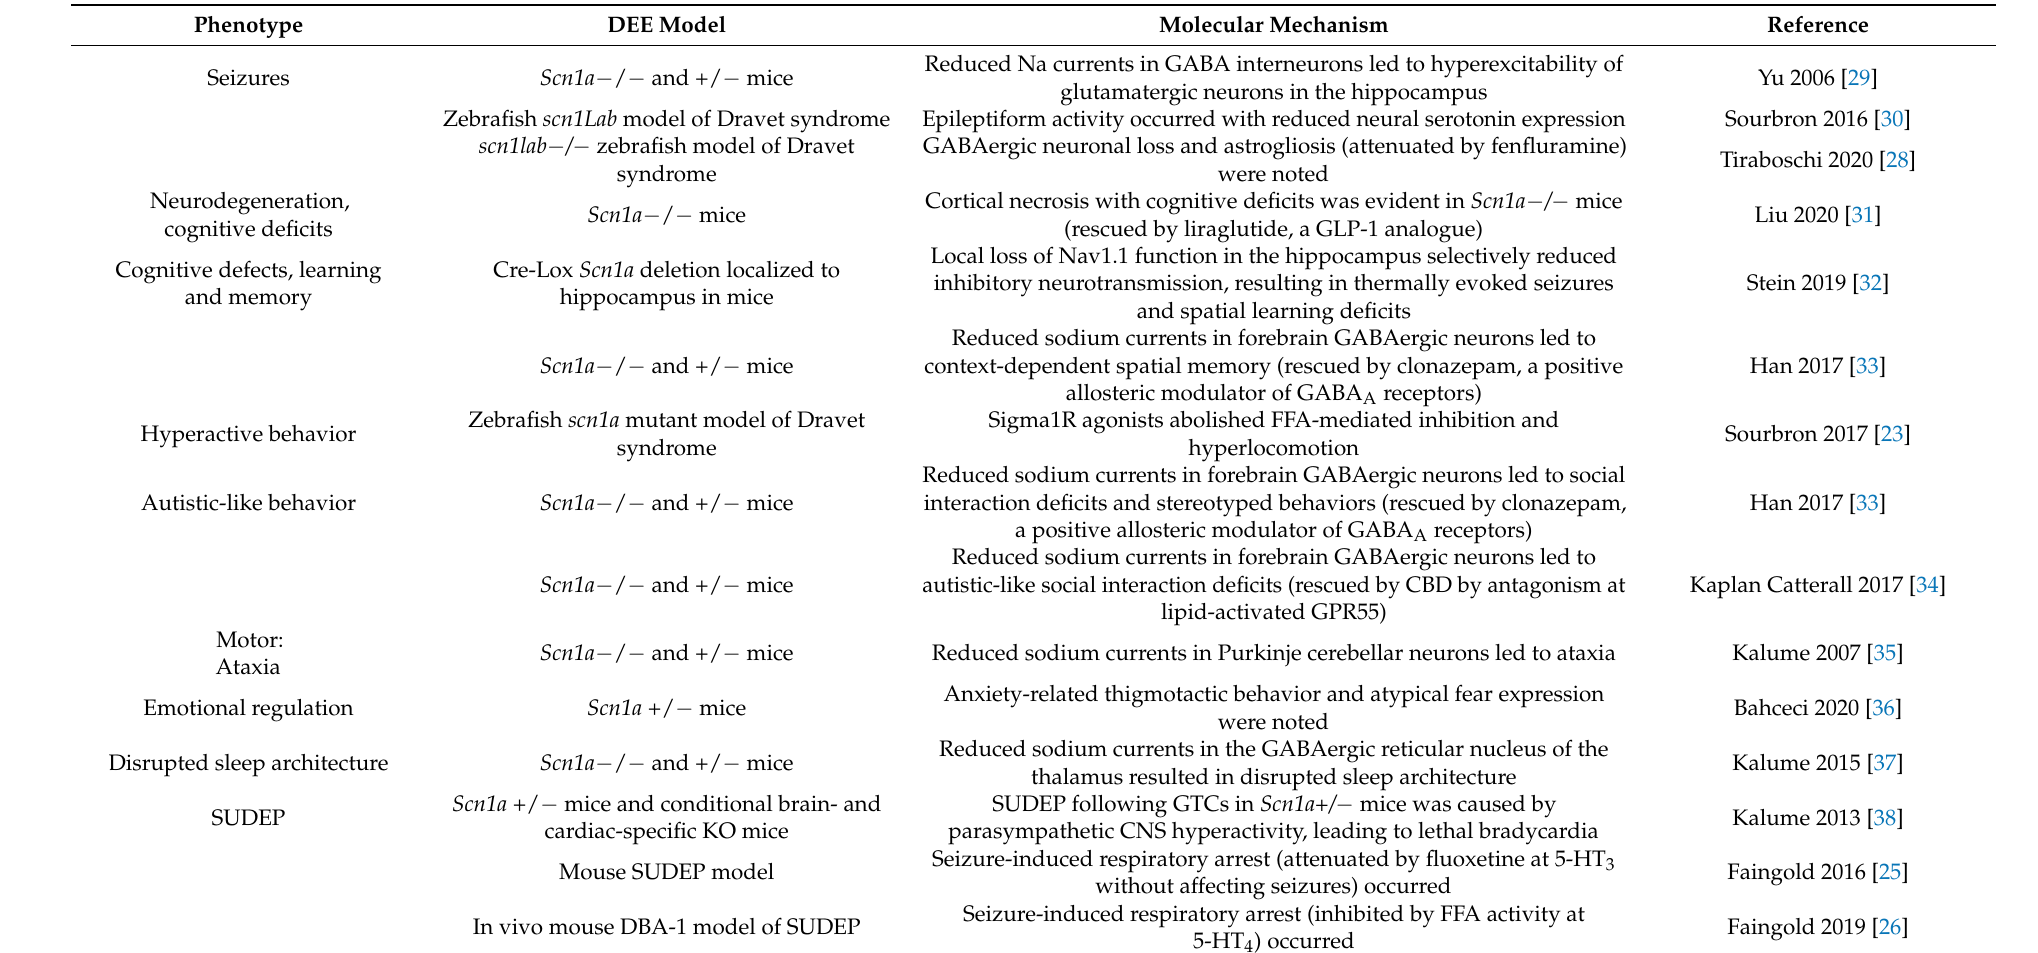
Table 1. Pharmacological targets for clinical phenotypes revealed by genetic models of Dravet